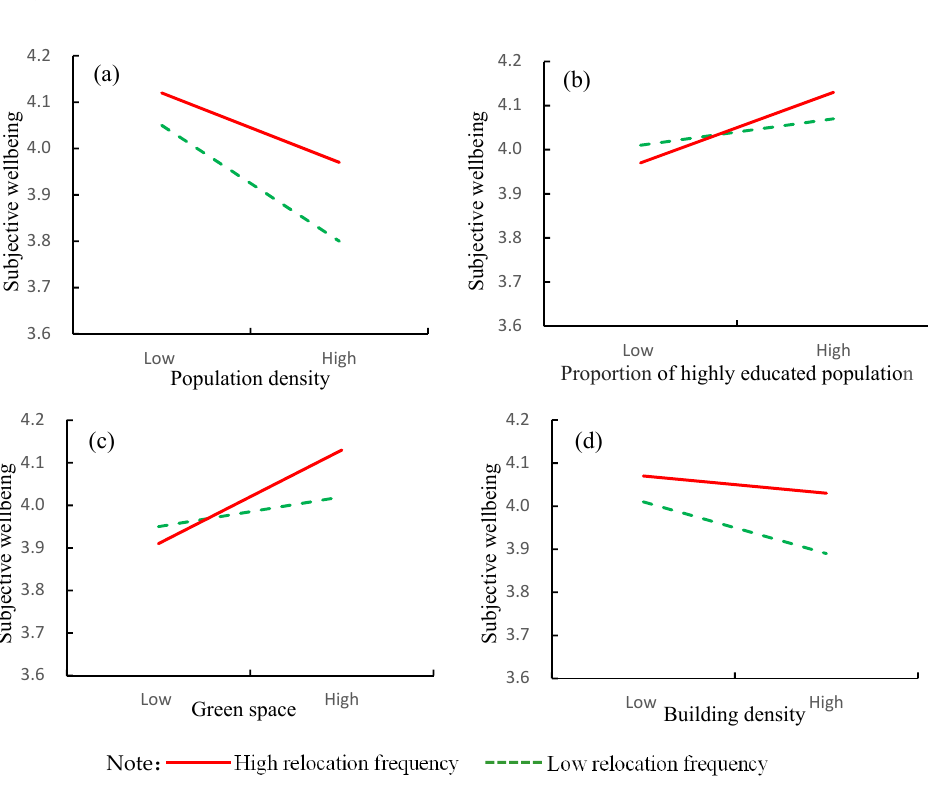
Figure 2. Moderating effect of relocation frequency.